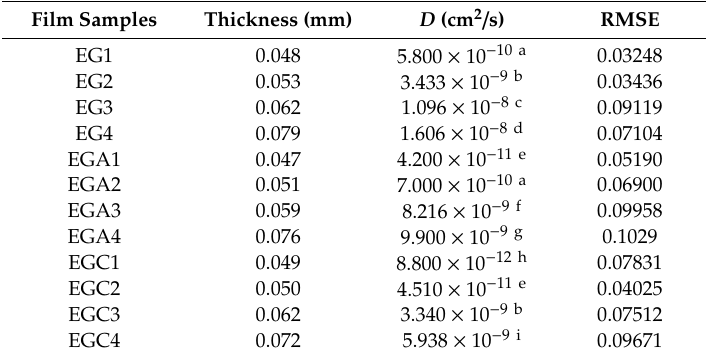
Figure 6. Experimental and theoretical values of one-way release tests of CEOs released at 4 ◦ C from films EG3 ( a – d ) and EGC1 ( e – h ) to aqueous ethanol with water content of 5%, 30%, 60%, and 95%. Table 4. Di ff usion coe ffi cients of one-way release of CEOs released from films to absolute ethanol at 4 ◦